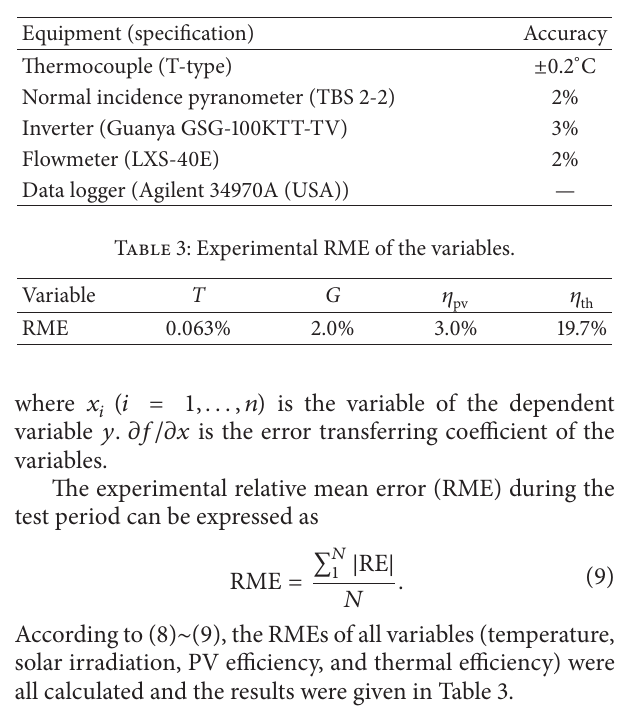
Table 2: The components of the test equipment.